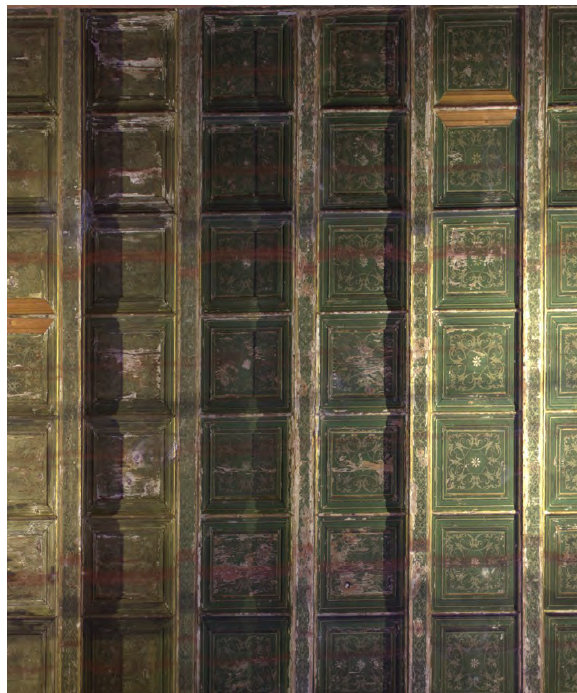
Figure 12. Detail of the ceiling coming from Photoscan